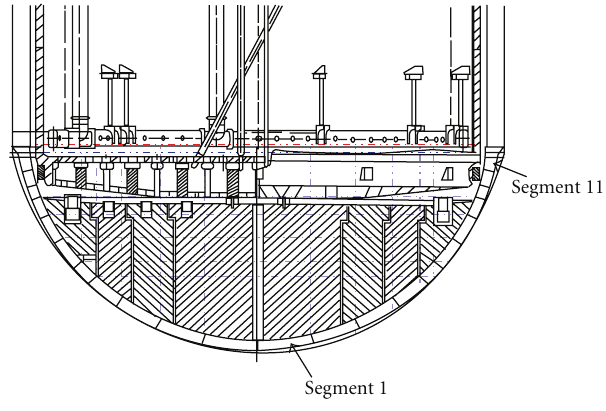
Figure 6: MELCOR model of RPV lower head.